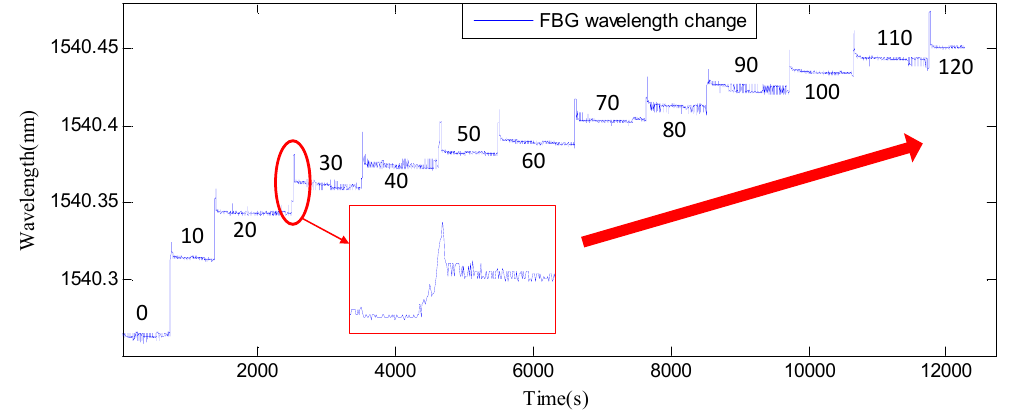
Figure 11. The Bragg wavelength change of the smart washer with the increased torque (Unit: N·m).